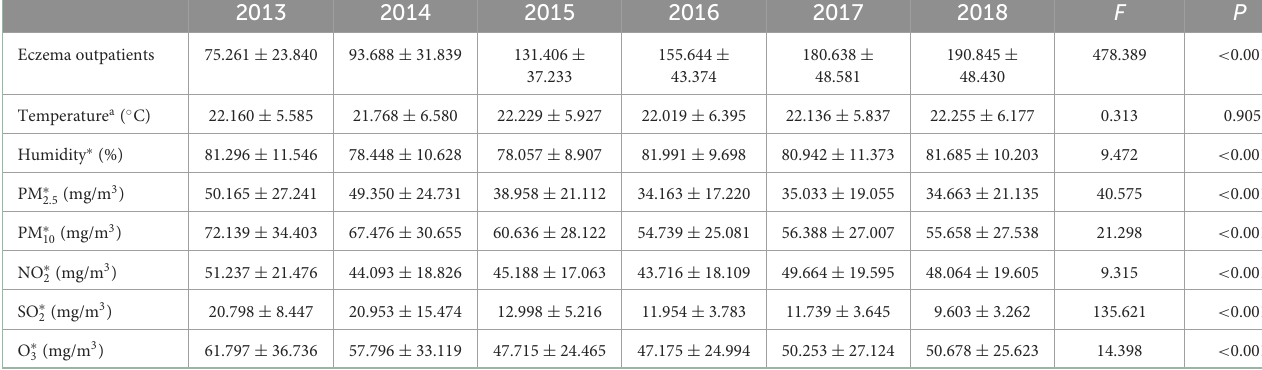
TABLE 1 Daily outpatients of eczema, meteorological factors and air pollutants in Guangzhou